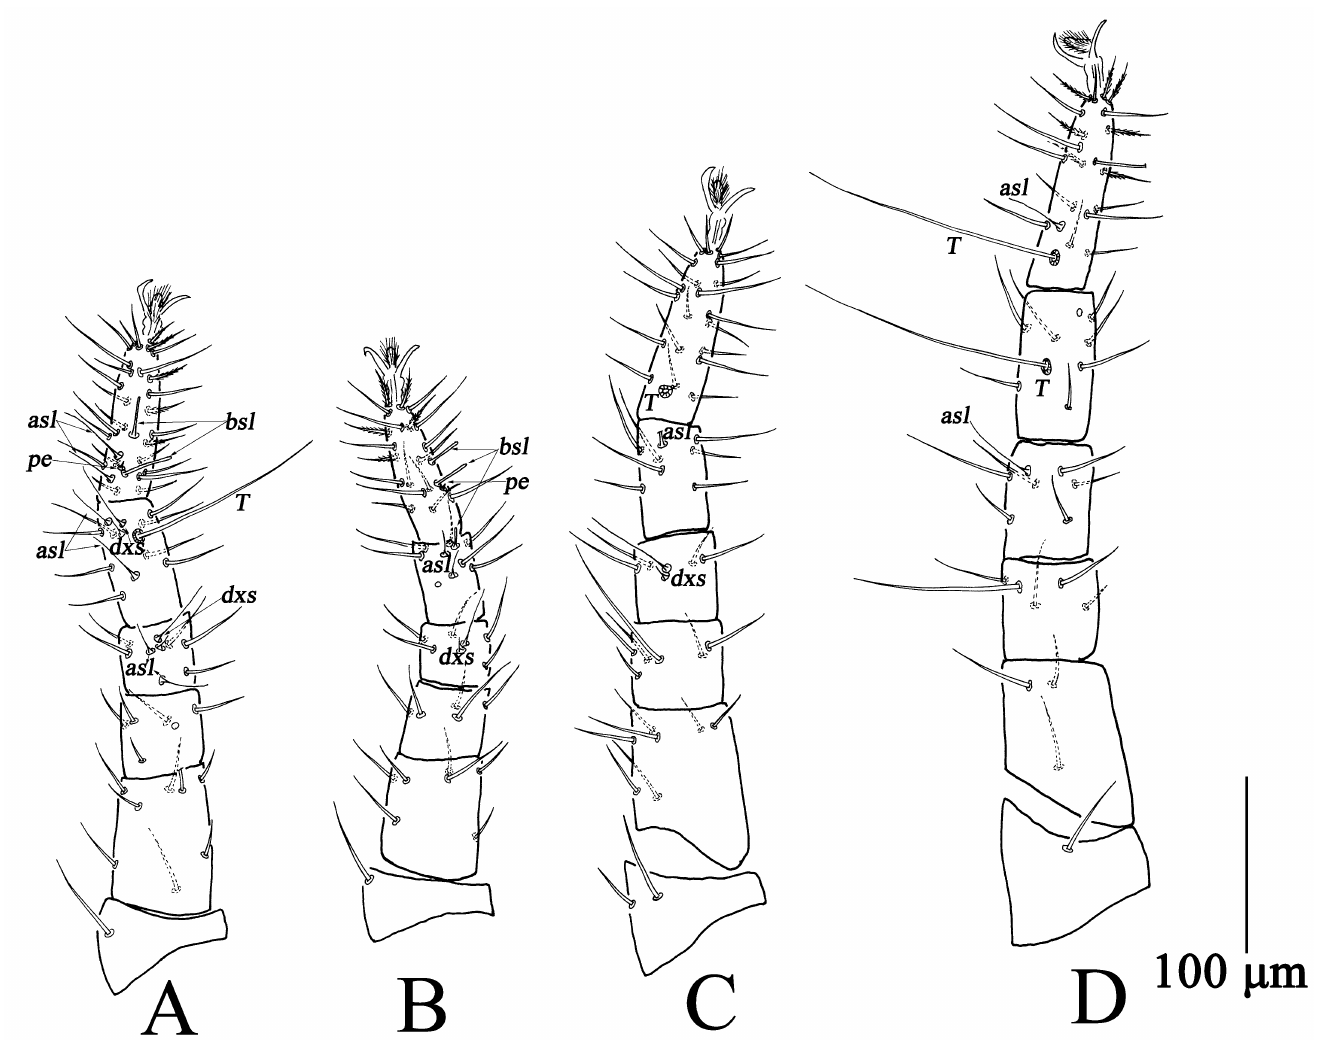
Figure 6. Bdella muscorum , tritonymph: ( A ) Leg I; ( B ) Leg II; ( C ) Leg III; ( D ) Leg